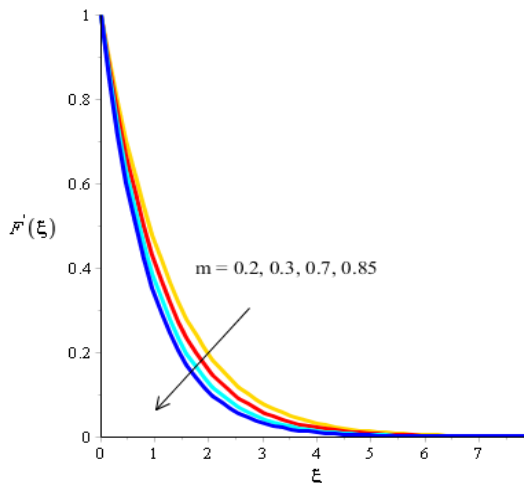
Figure 6. Analysis of velocity curves versus m .